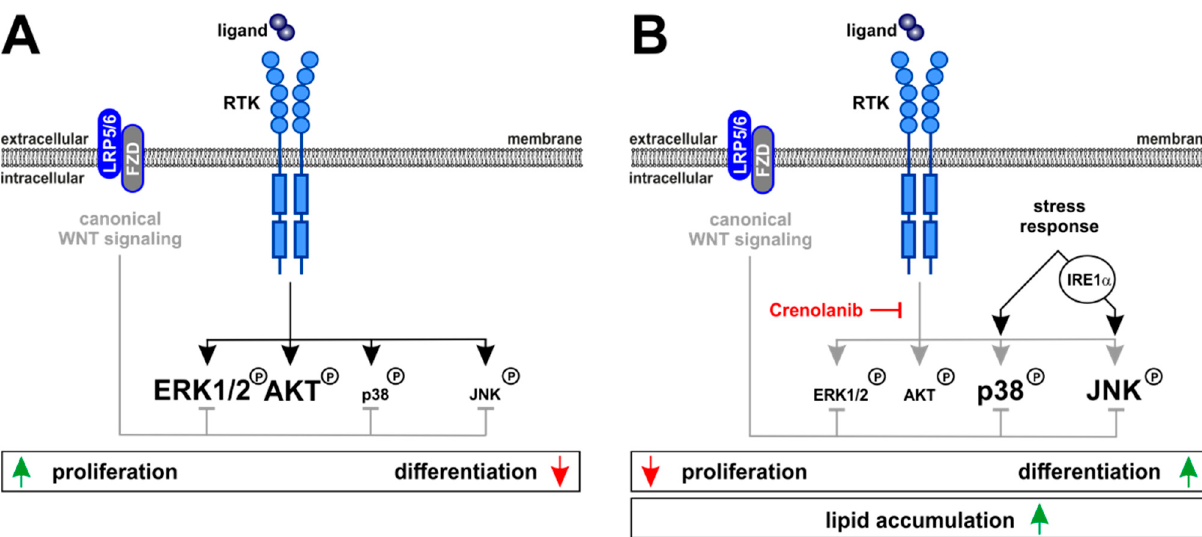
Figure 8. Schematic showing the molecular mechanisms that govern HSC behavior via Crenolanib. ( A ) The stimulation of RTK signaling using ligands, such as PDGF-BB, increases the phosphorylation of ERK1/2 and AKT, whereas p38 MAPK and JNK were only weakly phosphorylated after PDGF-BB exposure. ( B ) By contrast, blocking RTK signaling using Crenolanib led to p38 MAPK and JNK phosphorylation, resulting in reduced cell proliferation and the initiation of cell differentiation processes. Thus, RTK signaling was capable of balancing the opposing effects of cell proliferation and differentiation. In contrast, canonical WNT signaling suppressed proliferation and differentiation in HSC by inhibiting ERK1/2, p38 MAPK, and JNK activation, indicating that the regulatory functions of canonical WNT signaling are capable of sustaining quiescence in HSC. The accumulation of lipids, especially in response to high Crenolanib concentrations, suggested the activation of adaptive stress pathways and provided an explanation for p38 MAPK and JNK activation. IRE1 α was found to be responsible for Crenolanib-mediated JNK phosphorylation and endodermal specification of HSC.